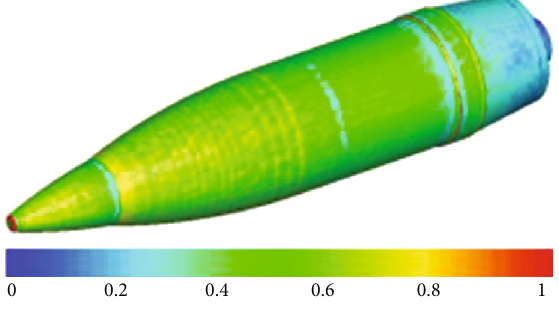
Figure 3: Wall unit, y + distribution. Table 1: Mach number versus rolling rate